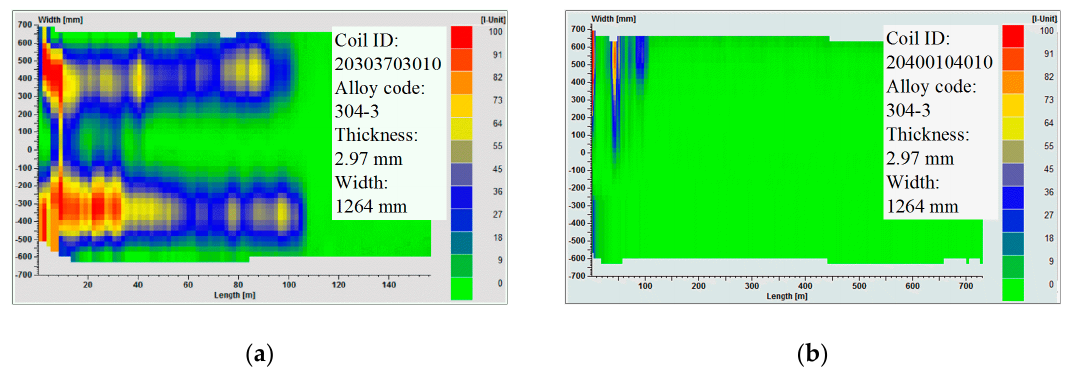
Figure 25. Comparison of the strip flatness detected by the on-line meter: ( a ) before optimisation; ( b ) after optimisation.